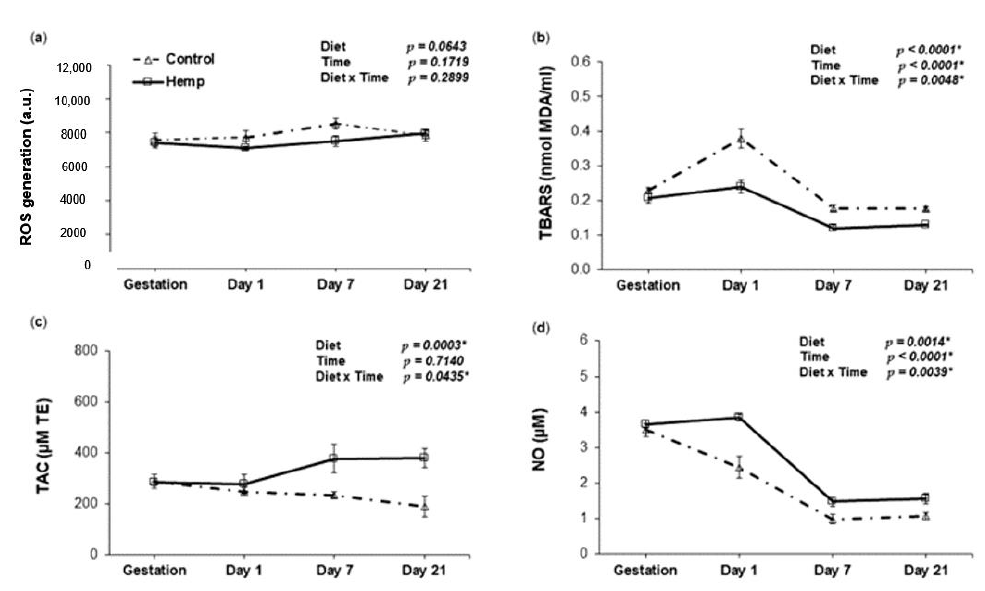
Figure 1. The e ff ect of HD on oxidative status in the plasma of sows throughout the lactation period. ( a ) Relationship between reactive oxygen species (ROS) and day of lactation in the plasma of sows fed a control ( ∆ symbol) or a hemp seed diet ( (cid:3) symbol); ( b ) Relationship between lipid peroxidation (TBARS) and day of lactation in the plasma of sows fed a control ( ∆ symbol) or a hemp seed diet ( (cid:3) symbol); ( c ) Relationship between total antioxidant activity (TAC) and day of lactation in the plasma of sows fed a control ( ∆ symbol) or a hemp seed diet ( (cid:3) symbol); ( d ) Relationship between NO and day of lactation in the plasma of sows fed a control ( ∆ symbol) or a hemp seed diet ( (cid:3) symbol). The p -values for the e ff ects of treatment (diet), time and diet-time interaction are shown. Data are means ± SEM ( n = 5). Asterisk (*) indicates significance ( p < 0.05